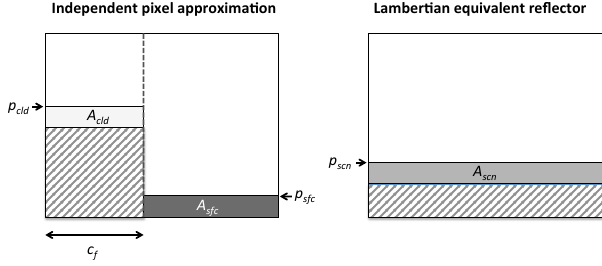
Figure 1. The independent pixel approximation versus the Lamber- tian equivalent reflectance model. In the IPA a ground pixel is mod- elled as the weighted sum of a cloudy part, (a Lambertian surface with an albedo of A cld at a pressure level p sfc ) and a clear part (a Lambertian surface with an albedo of A sfc at a pressure level p sfc ). The top-of-atmosphere reflectance is computed as the weighted av- erage of the cloudy and clear parts, using the effective cloud frac- tion c f for the weighting. The IPA method requires knowledge on A sfc ,A cld and p sfc . In the LER model the ground pixel is modelled as a Lambertian surface with an albedo A scn at a pressure level p scn . Note that the hatched areas below the opaque Lambertian indicate that these regions do not contribute in the radiative transfer calcula-